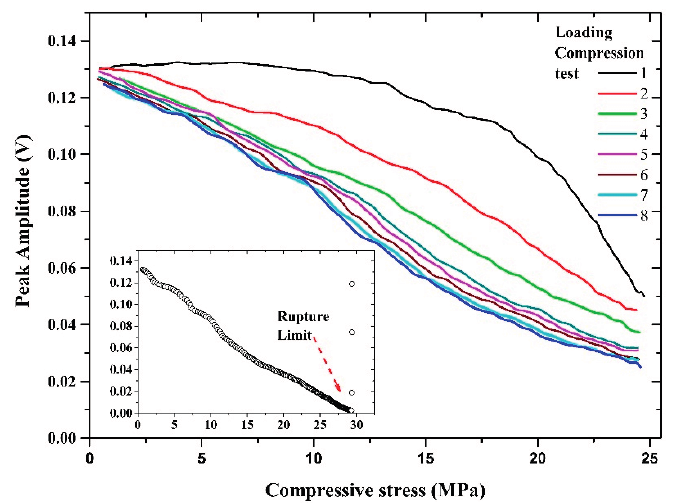
Figure 9. Variation of the peak amplitude of embedded MMCC